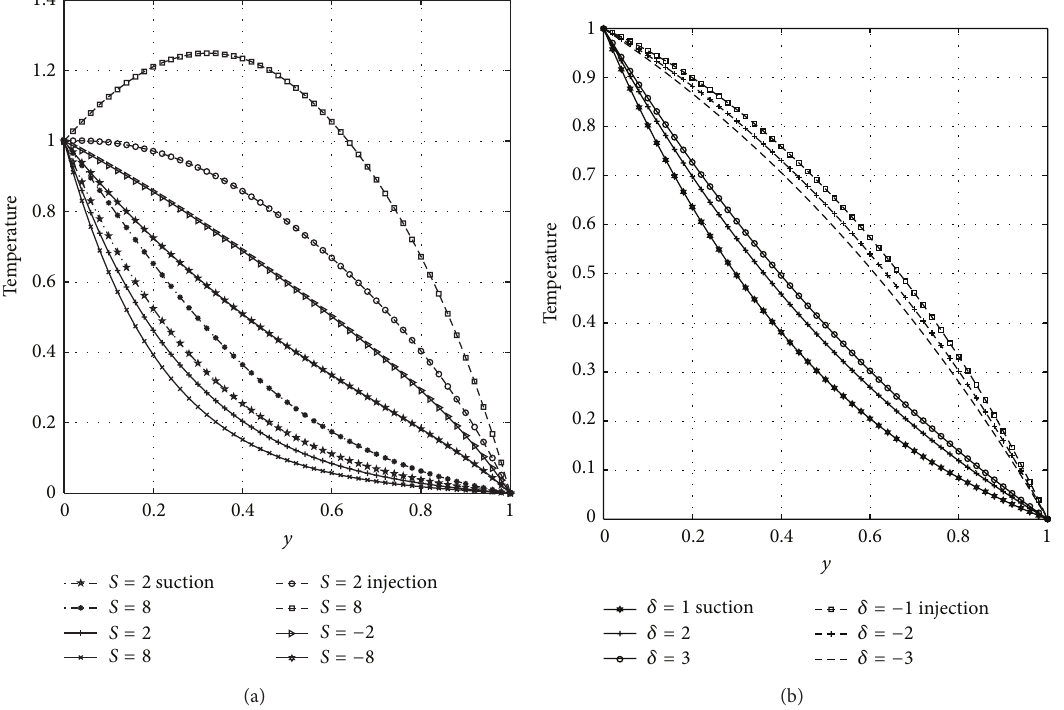
Figure 7: Effects of heat source/sinks (𝑆) and variable thermal conductivity ( 𝛿 ) on temperature.